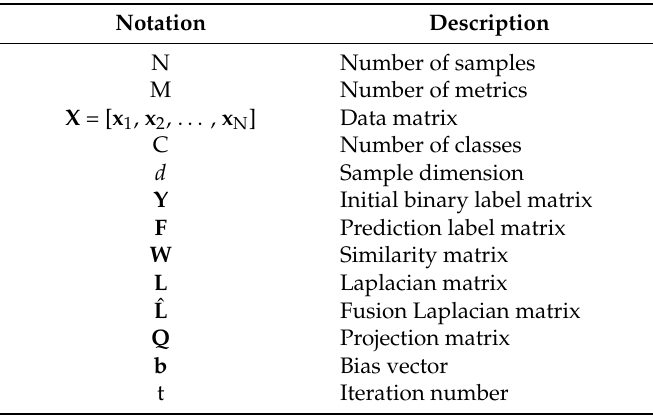
Table 1. List of mathematical